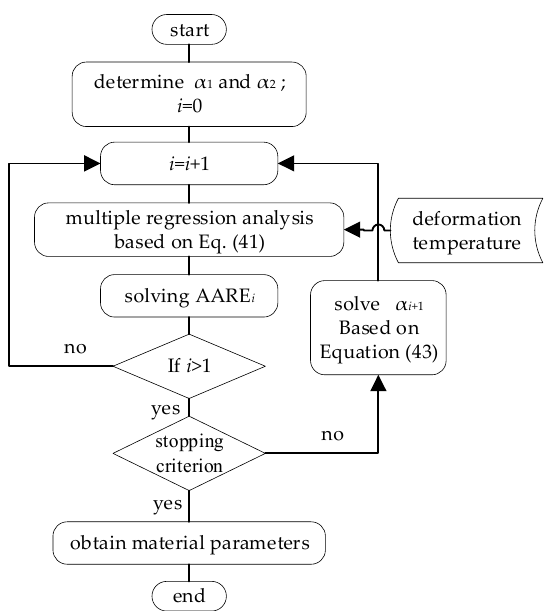
Figure 17. Process of solving the material parameters in the modified Hensel–Spittel (mHS) equation by combining multiple regression analysis with a linear search.